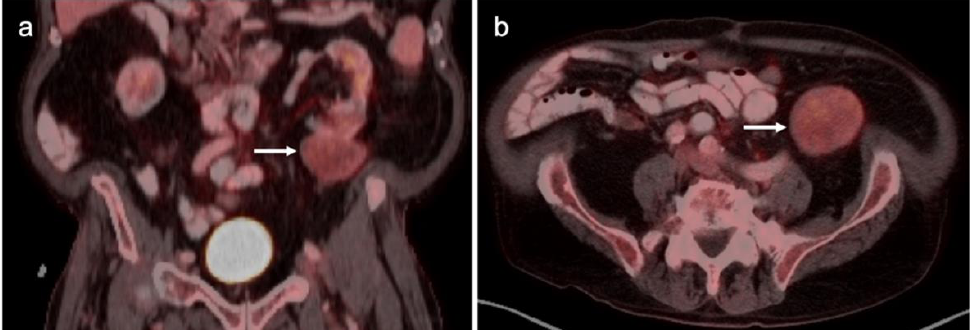
Figure 46. Renal cell carcinoma. FDG PET-CT coronal ( a ) and axial ( b ) images. An exophytic mass (white arrows) arising from the inferior pole of the left kidney is slightly higher in metabolic activity than normal renal parenchyma. This is typical for renal cell carcinoma, which can also be similar in metabolic activity to the renal parenchyma.